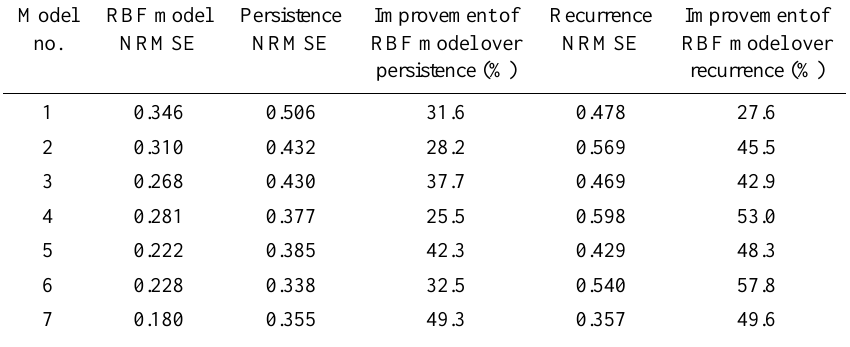
Table 2. Comparison of RBF model normalized root-mean-squared errors (NRMSE) with persistence and 24-hour recurrence model NRMSE Model RBF model Persistence Improvement of Recurrence Improvement of no. NRMSE NRMSE RBF model over NRMSE RBF model over persistence (%) recurrence